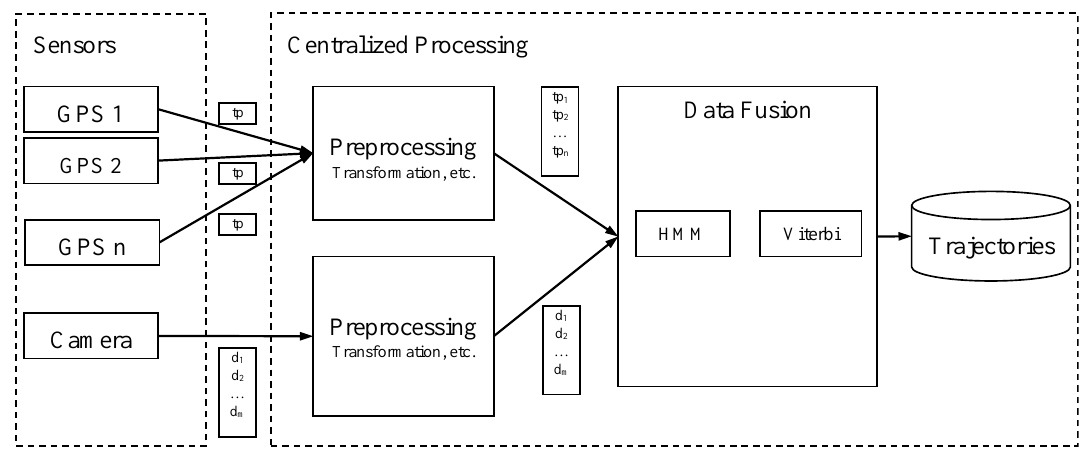
Figure 1. Overall structure of our